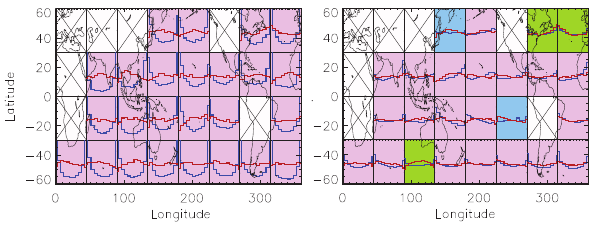
Fig. 7. Talagrand diagrams (as in Fig. 4) for 0–700m salinity for the lagged (blue line) and bred (red line) initialized ensembles for lead times of one month (left), and one year (right).